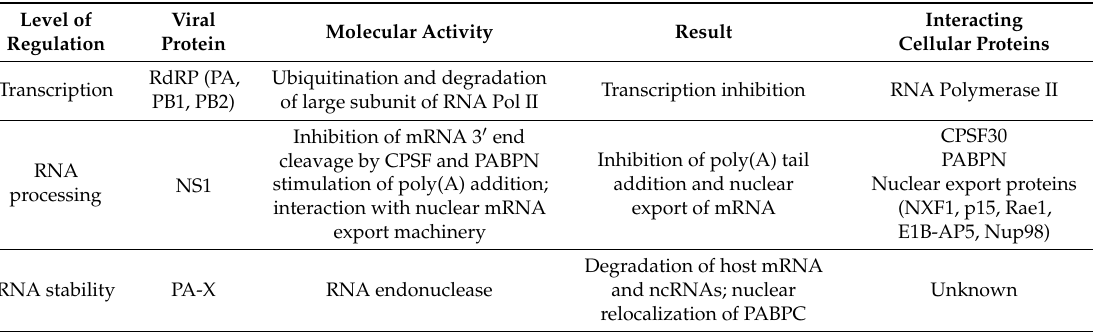
Table 3. Host shutoff mechanisms in influenza A